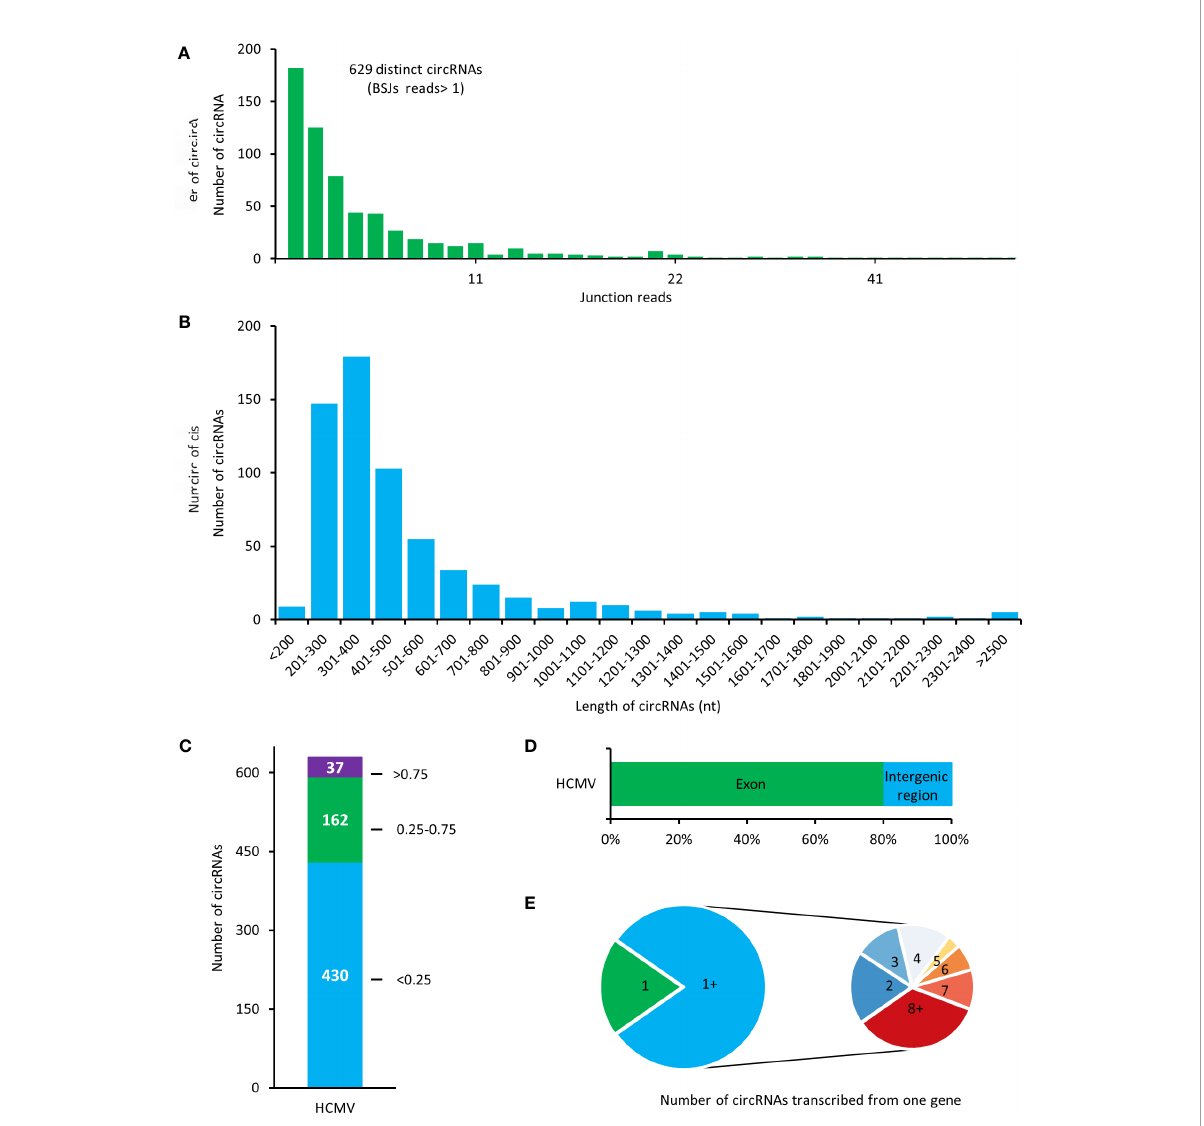
FIGURE 2 Expression patterns of HCMV-encoded circRNAs in HELF cells. (A) The total numbers of HCMV-encoded circRNAs and BSJs read identi fi ed in this study. (B) Length distribution of HCMV-encoded circRNAs. (C) Distribution of spliced reads per billion mappings (SRPBM) of HCMV-encoded circRNAs. (D) Classi fi cation of circular HCMV-encoded RNAs based on the genomic origin. (E) The number of viral circRNAs transcribed from one